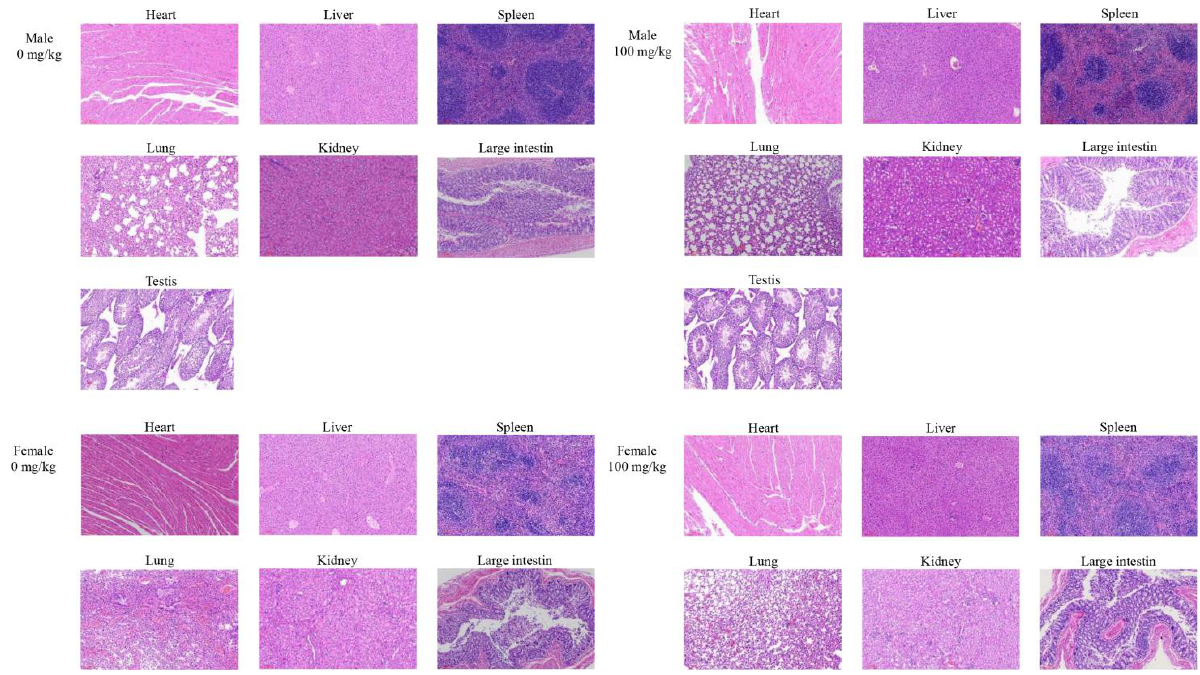
Figure 8. Body weight changes of mice in the repeated-dose 30-day oral toxicity study: ( A ) male; ( B ) female. Data are presented as mean ± SD ( n = 10/sex/group).